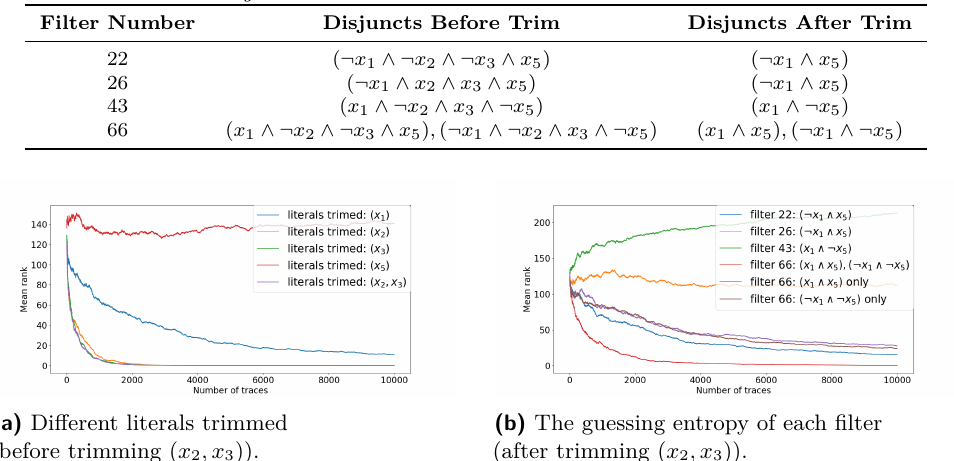
Figure 14: Guessing entropy obtained when applying step 1 and 2 on the modified TTSCA big trained on ASCADv1_f. Table 6: Disjuncts with CoL for ( x 1 , x 2 , x 3 , x 5 ) before and after trimming ( x 2 , x 3 ) using the modified TTSCA big .